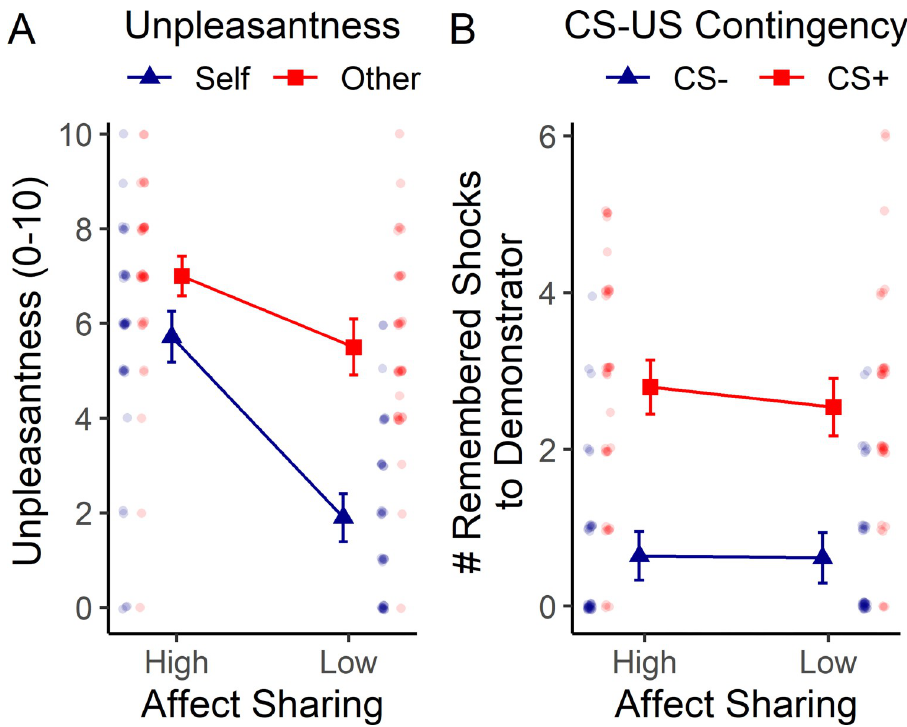
Fig 4. Results of the post-hypnosis interview showing the effects of hypnotic suggestions for high / low affect sharing on ratings of affect sharing, emotion recognition and declarative memory of the contingency between CS (colored square) and US (shock / no shock to demonstrator). a) Participants rated how unpleasant the shocks were for the demonstrator in the video (emotion recognition–blue / dark lines) and how unpleasant it was for themselves to watch the shocks being delivered to the demonstrator (affect sharing–red / bright lines). b) Participants indicated how many shocks the demonstrator had received following the CS+ and CS-, respectively. Error bars reflect 95% confidence intervals corrected for within-subject designs (see Methods). CS–conditioned stimulus; US–unconditioned stimulus. Results of individual participants are shown laterally as semi-transparent dots.